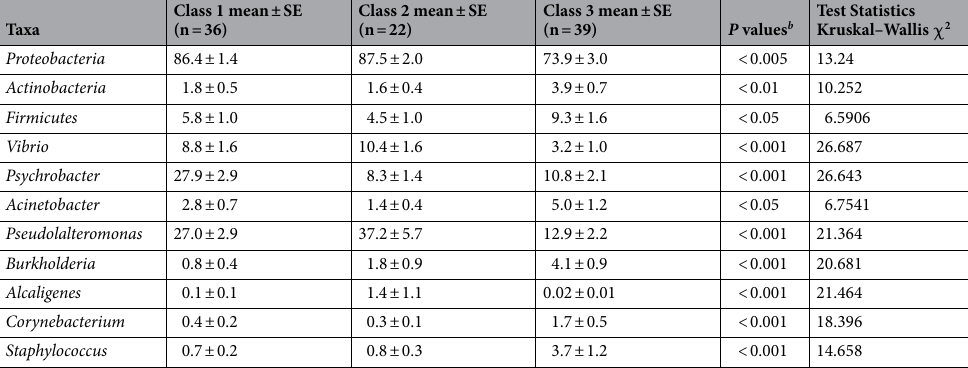
Table 5. Mean relative abundance (%) of the discriminative taxa found in the cmDNA of Greenland halibuts ( R. hippoglossoides ) according to the size classes. a Values are expressed as